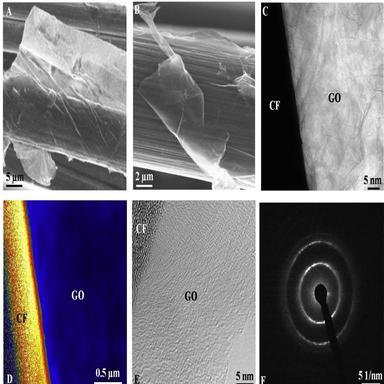
SEM images of graphene oxide grafted on CF at (A) 5μ and (B) 2μ scale and EFTEM images of GO grafted on CF (C) Bright field image (D) Thickness map (E) High resolution TEM (HRTEM) and (F) Electron diffraction pattern of GO.